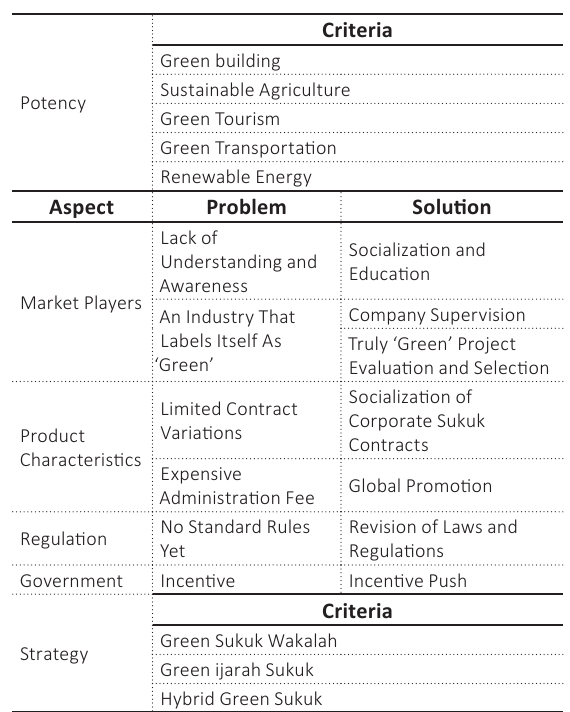
Table 1. Factors and criteria for issuance of corporate green Sukuk in Indonesia